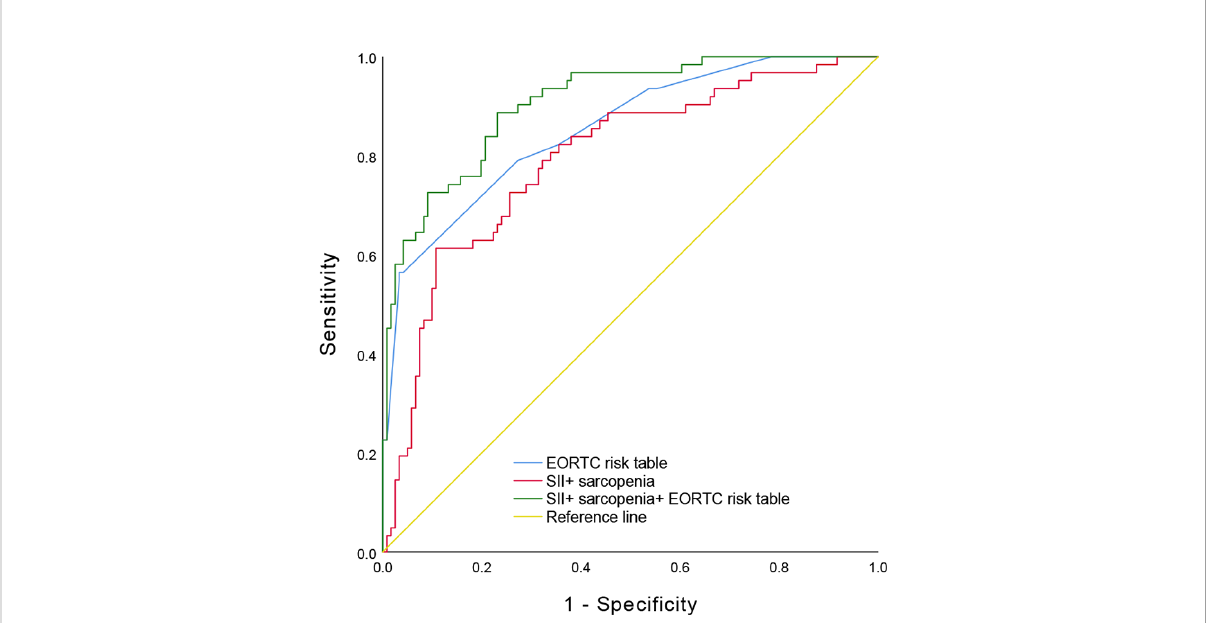
FIGURE 3 The receiver operating characteristic curve comparing preoperative sarcopenia and SII with EORTC risk table. SII, Systemic Immune-In fl ammation Index; EORTC, European Organization for Research and Treatment of